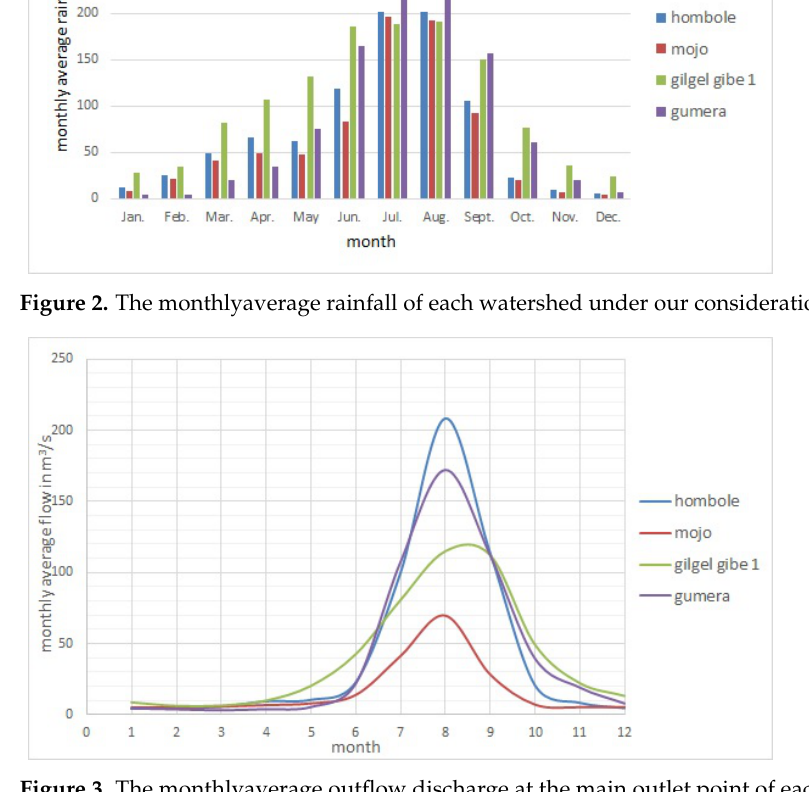
Figure 3. The monthlyaverage outflow discharge at the main outlet point of each watershed under our